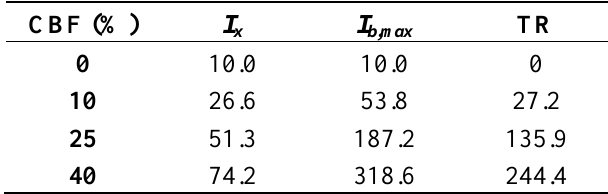
is the b,max − I b,max x